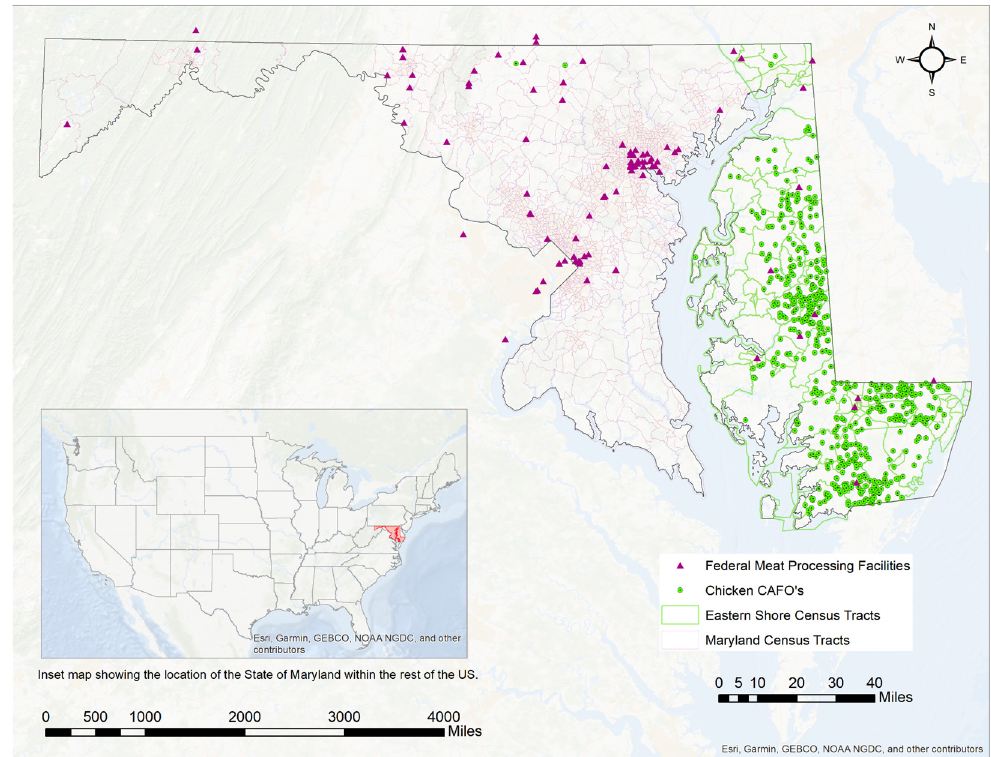
Figure 1. Locations of CAFOs and Federal Meat Processing Facilities in Maryland.